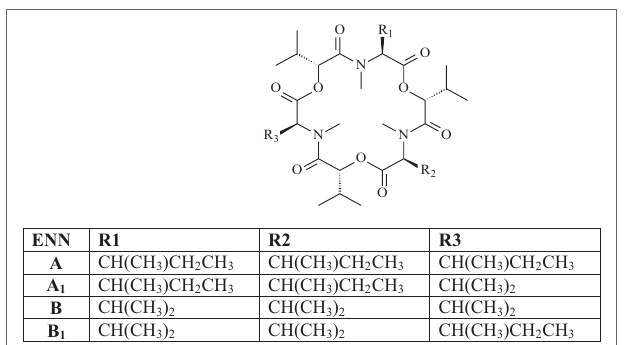
FiGURe 1 | Chemical structure of enniatins (ENNs).